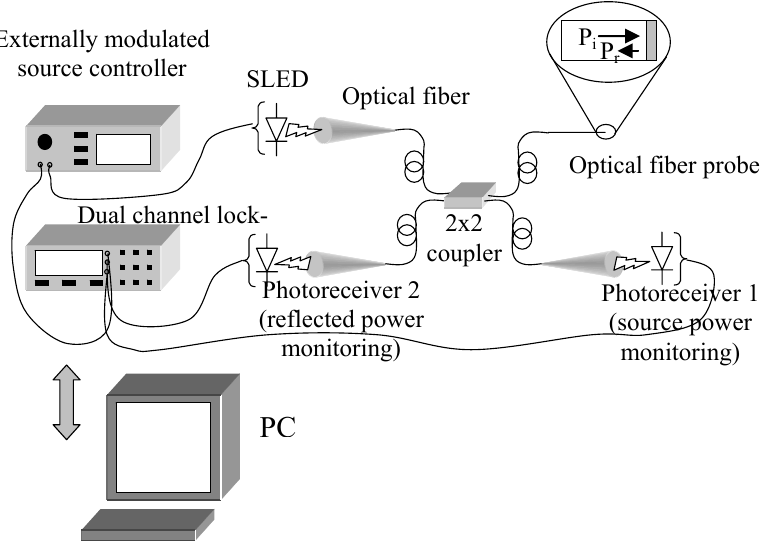
Figure 16. Schematic of the reflectometric interrogation